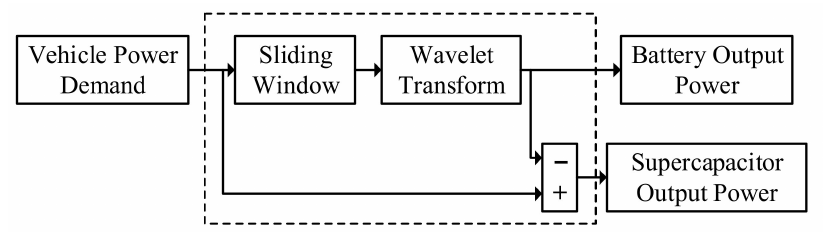
Figure 6. Framework of the energy management